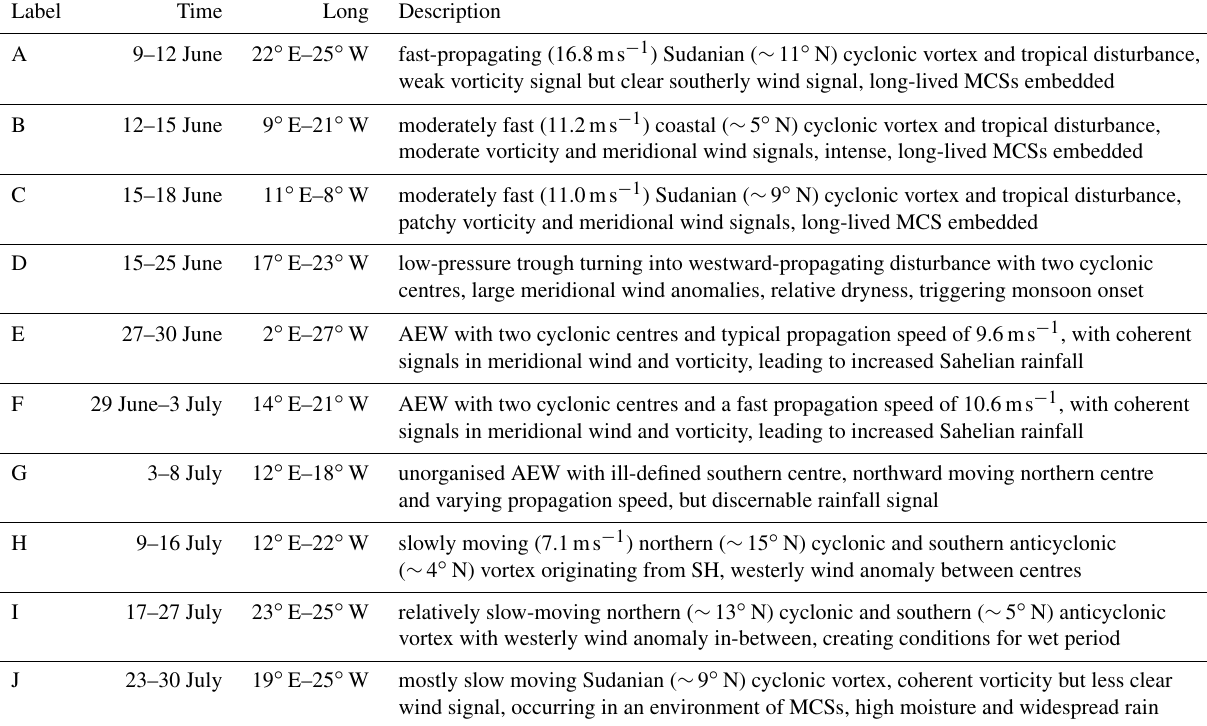
Table 1. Characterisation of the labelled (Column 1) synoptic-scale features. Columns 2 and 3 give the time period and longitude range for which a coherent vortex was tracked in 850hPa streamlines (see Figs. 11, 13, 14 and 16). Column 4 gives a general description, including aspects such as propagation speed, latitude and reflection in wind and vorticity